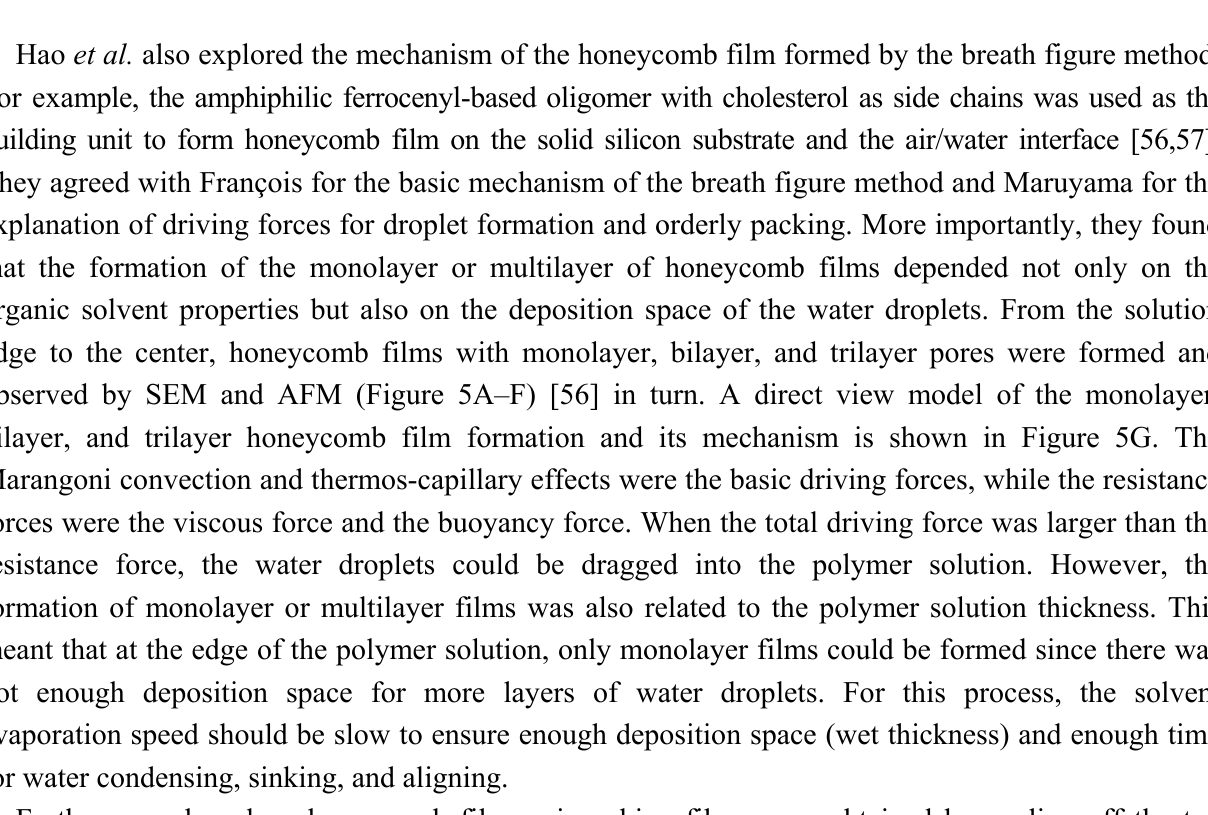
Figure 4. Top view of the honeycomb structure formation mechanism of polyion complexes, with copyright permission from